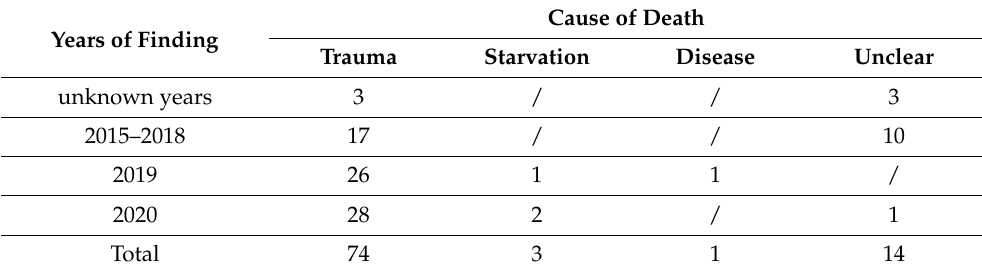
Table 5. Causes of death of 92 Eurasian otters found in Schleswig-Holstein between 2015–2020. Cause of Death Years of Finding Trauma